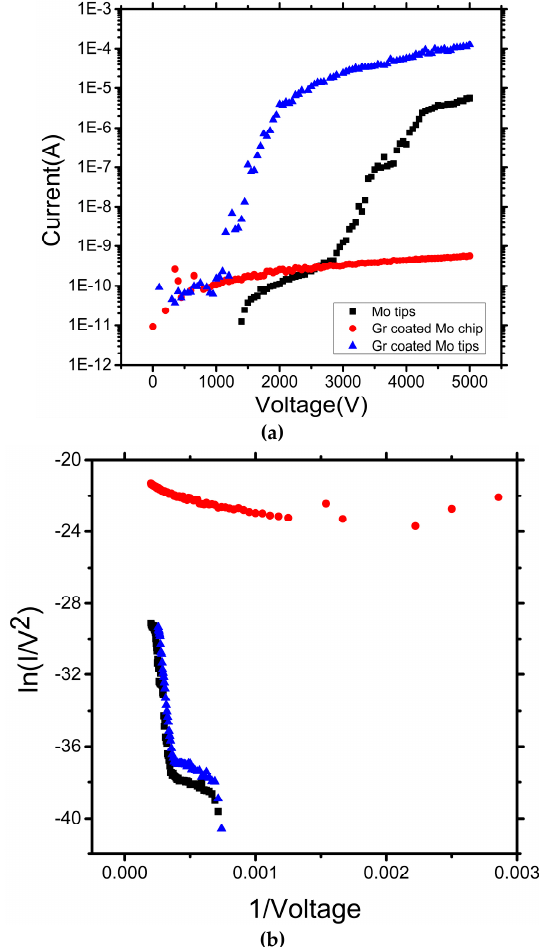
Figure 8. ( a , b ) I-V curves of Mo tips, graphene-coated Mo chip and graphene-coated Mo tip array cathodes. ( b ) Corresponding FN plots.